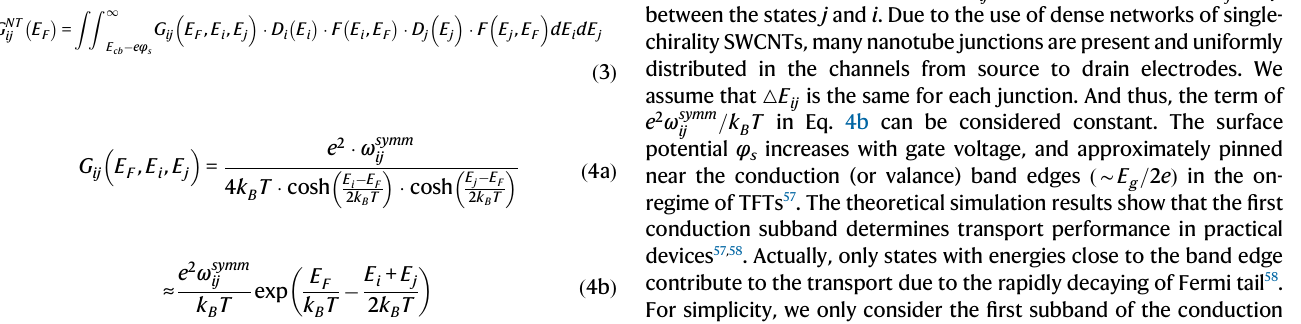
n -branch.BlueandredsymbolsrepresentTypeIandTypeIISWCNTs,respectively. Theblackdashedarrowsshowthechangetrendoftheon-statecurrentandcarrier mobility with increasing diameter. Error bars in the Figure are the standard deviation of